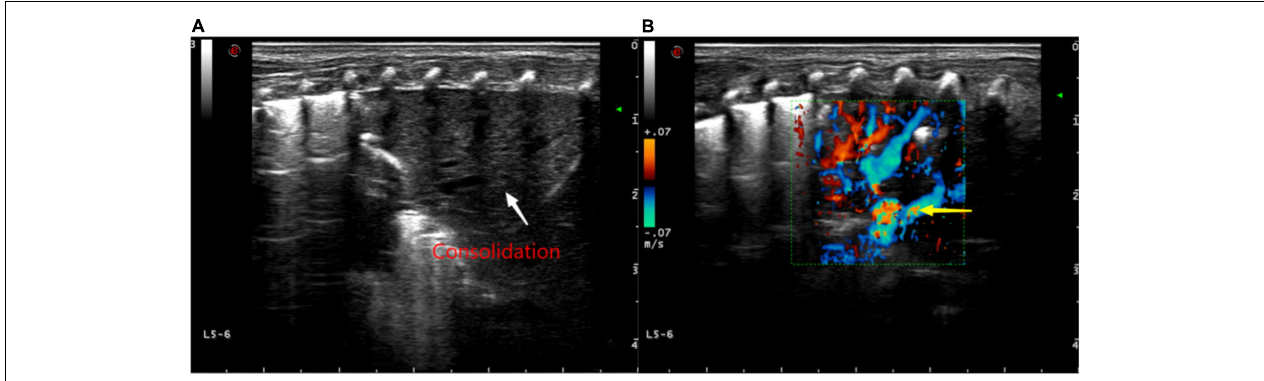
FIGURE 6 | (A) Ultrasound findings of a large consolidation in areas 5–6 of the neonatal left lung. Lung ultrasound shows a large area with the “tissue-like sign” similar to the echo of the liver, spleen, and other tissues (white arrow) and the disappearance of the pleural line and A-line. (B) Color Doppler ultrasound showing blood flow with “dendritic” distribution in the area of consolidation (yellow arrow). TABLE 1 | Comparison of different pulmonary ultrasound signs and chest X-ray (CXR) findings for the diagnosis of neonatal ventilator-associated pneumonia (NVAP). Examination method Clinical diagnosis of NVAP